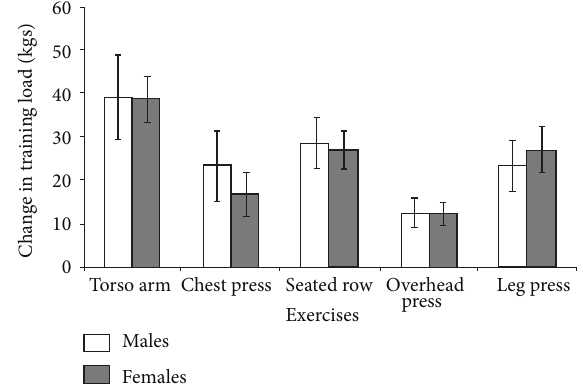
Figure 1: Mean change in absolute training load with 95% CIs for males and females.